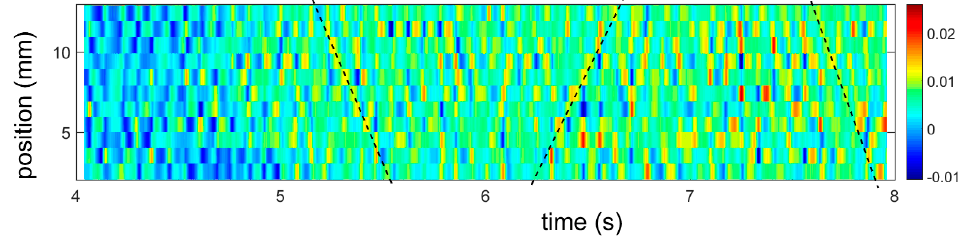
Figure 7. Portion of a spatiotemporal pattern for an RD specimen deformed at 8 × 10 − 3 s − 1 . Inclined dashed lines provide visual guidance indicating an ordering of the intermittent plastic activity (bright spots) into a wave-like propagation along the specimen centerline. A detailed analysis of the local strain-rate behavior will be published elsewhere.